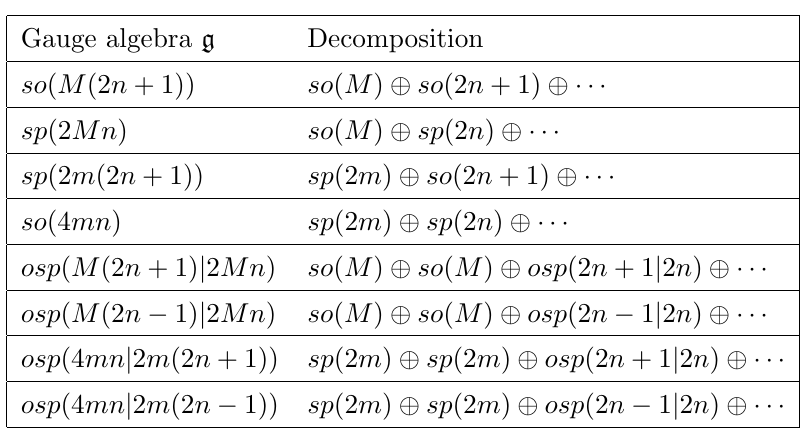
Table 1 . 8 types of restricted matrix extension for Chern-Simons gauge algebra. The gravitational (or supergravitational) sector is identi(cid:12)ed with the principally embedded sl (2) in so (2 n + 1) or sp (2 n ) (or osp (1 j 2) in osp (2 n (cid:6) 1 j 2 n